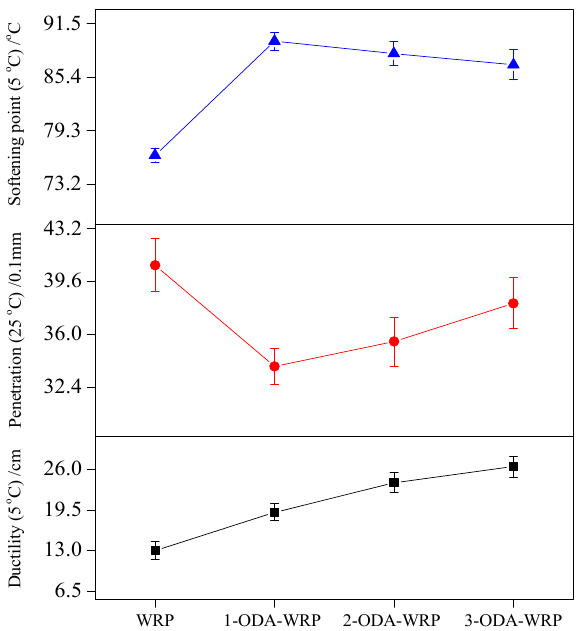
Figure 3. E ff ect of di ff erent WRPs on the performance of WRP / SBS-modified Figure 3. Effect of different WRPs on the performance of WRP/SBS-modified asphalt. 131